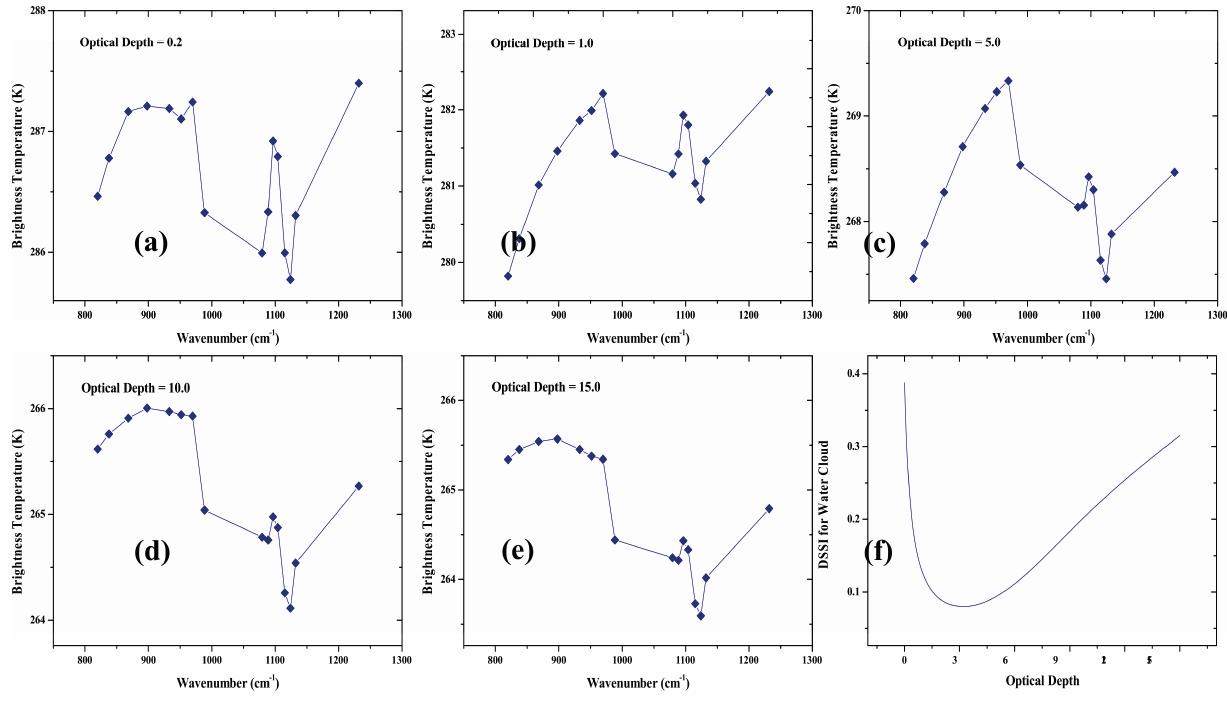
Figure 5. ( a–e ) The simulated nadir-viewed spectral brightness temperatures of selected AIRS channels for five different water cloud optical depths (0.2, 1.0, 5.0, 10.0 and 15.0). ( f ) The variation trend of DSSI under the condition of water